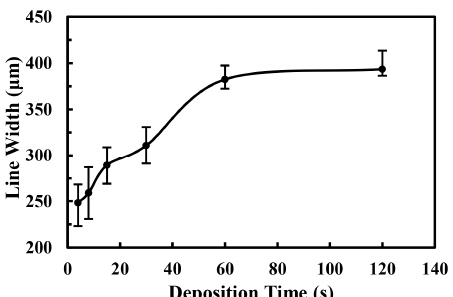
Figure 4. The effect of deposition time on the electrospray line width. The applied voltage, the flow rate of solution, the velocity of substrate, the distance between nozzle and collector were 1.5 kV, 50 μ L/h, 5 mm/s, and 5 mm, respectively.